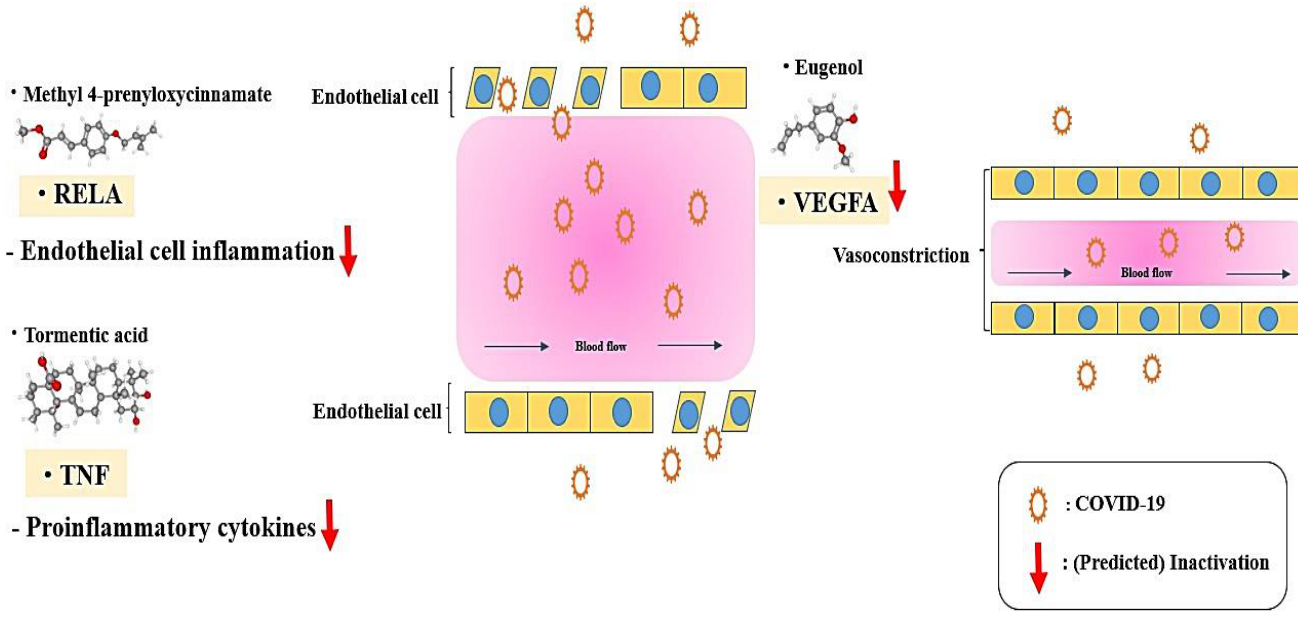
Figure 8. The potential mechanism effectors of LE against COVID-19.